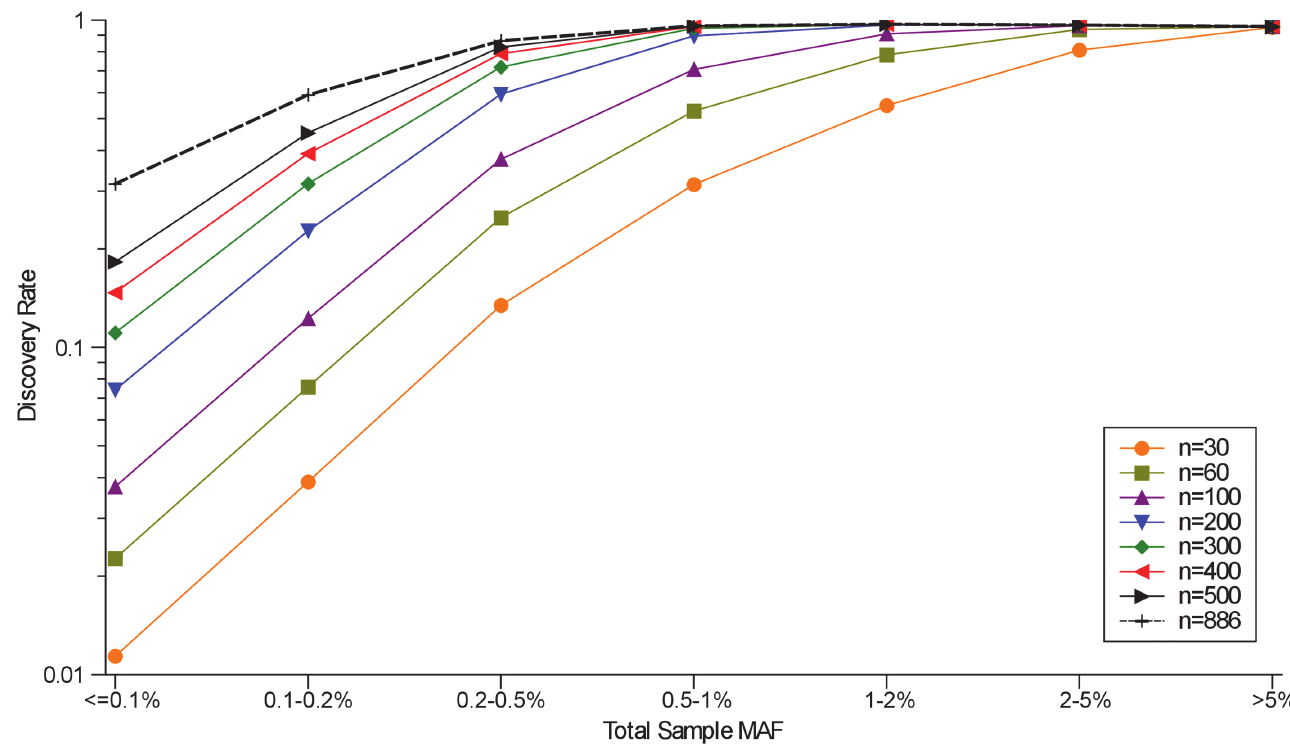
Fig 1. SNP rediscovery rate increases with increasing sample size when using the whole exome sequencing results as the gold standard. The dotted line shows the discovery rates of the total 886 individuals with WGS data. Each point is an average of 100 subsamples of size n from 886 individuals. Bootstrap resampling without replacement was carried out for each data point at various sample